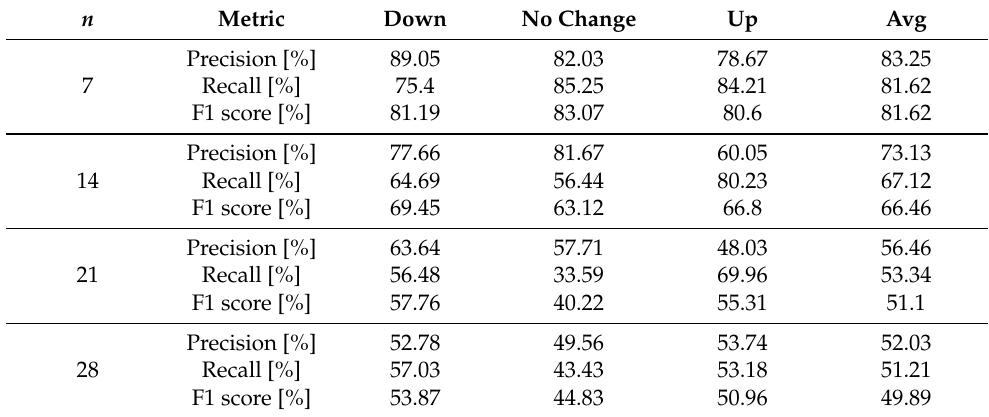
Table 5. Classification results [%] for data from tour operator T1 and series length 3.